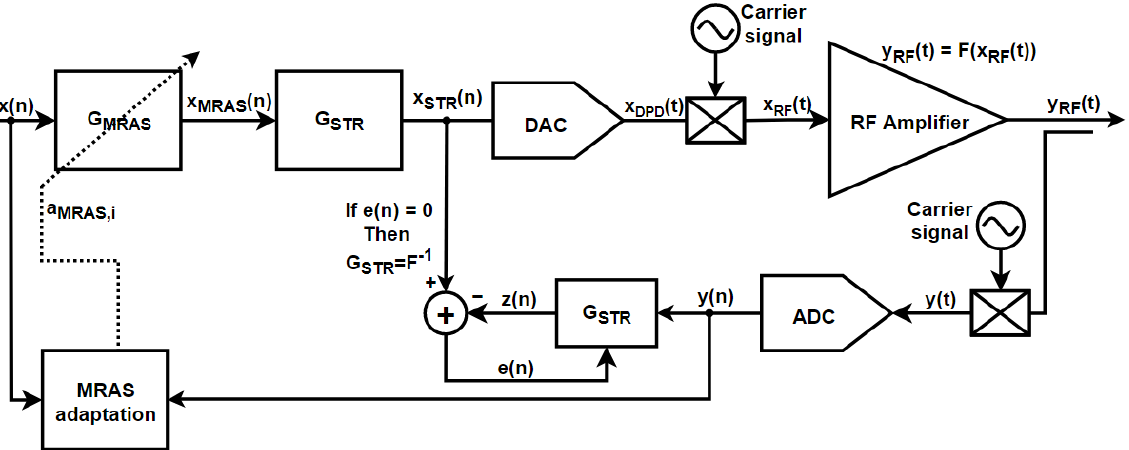
Figure 13. MRAS-STR transmitter.